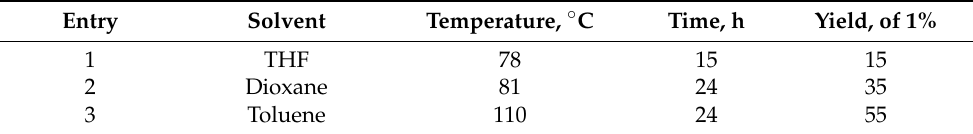
Table 1. Reaction of 4,7-dibromo-[1,2,5]thiadiazolo[3,4- d ]pyridazine 1 with 4-methoxy- N -(4-methoxyphenyl)- N -(4-(tributylstannyl)phenyl)aniline 2